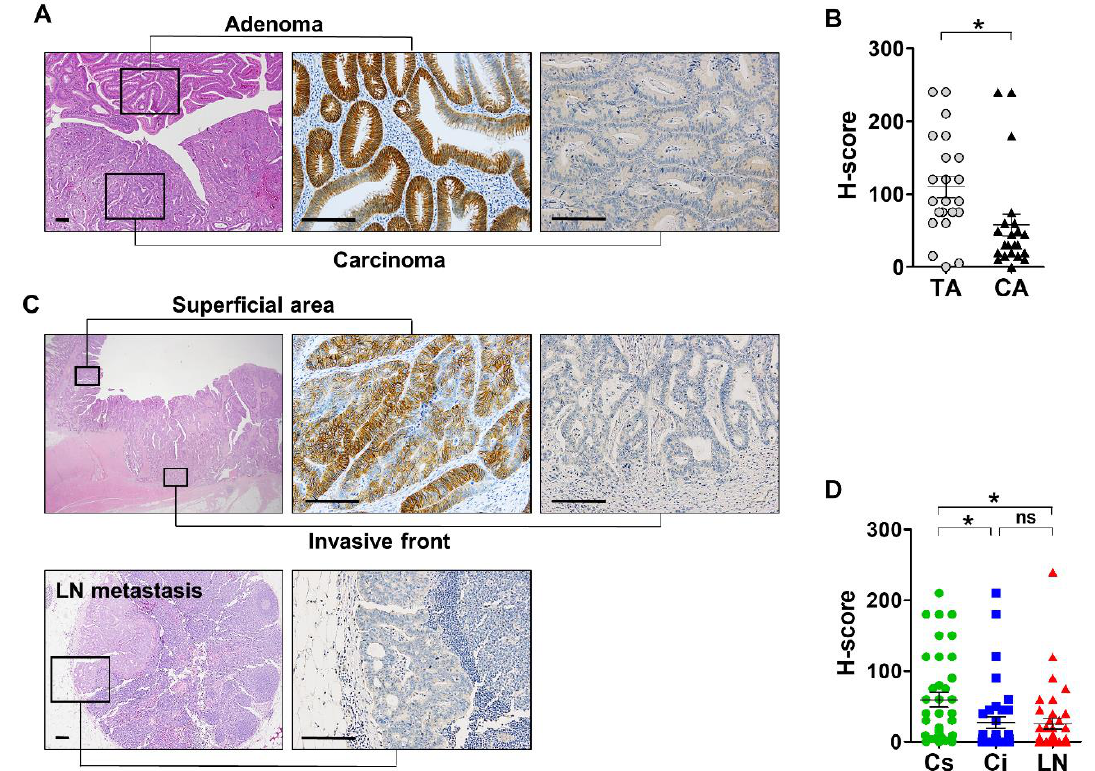
Figure 3. Decline of EPHB3 expression during colorectal cancer progression. ( A , B ) In colorectal cancers arising within an adenoma background ( n = 22), EPHB3 expression was significantly lower in carcinoma-rich regions than in adenoma-rich regions. ( C , D ) EPHB3 expression was examined in ulcerofungating cancers with lymph node metastases ( n = 37). Histo-scores of EPHB3 gradually decreased when cancer cells invaded into muscle layers and metastasized to lymph nodes. Data are presented as the mean ± SEM. SEM: standard error of the mean. ns, not significant. * p < 0.05. Scale bars: 50 μm.